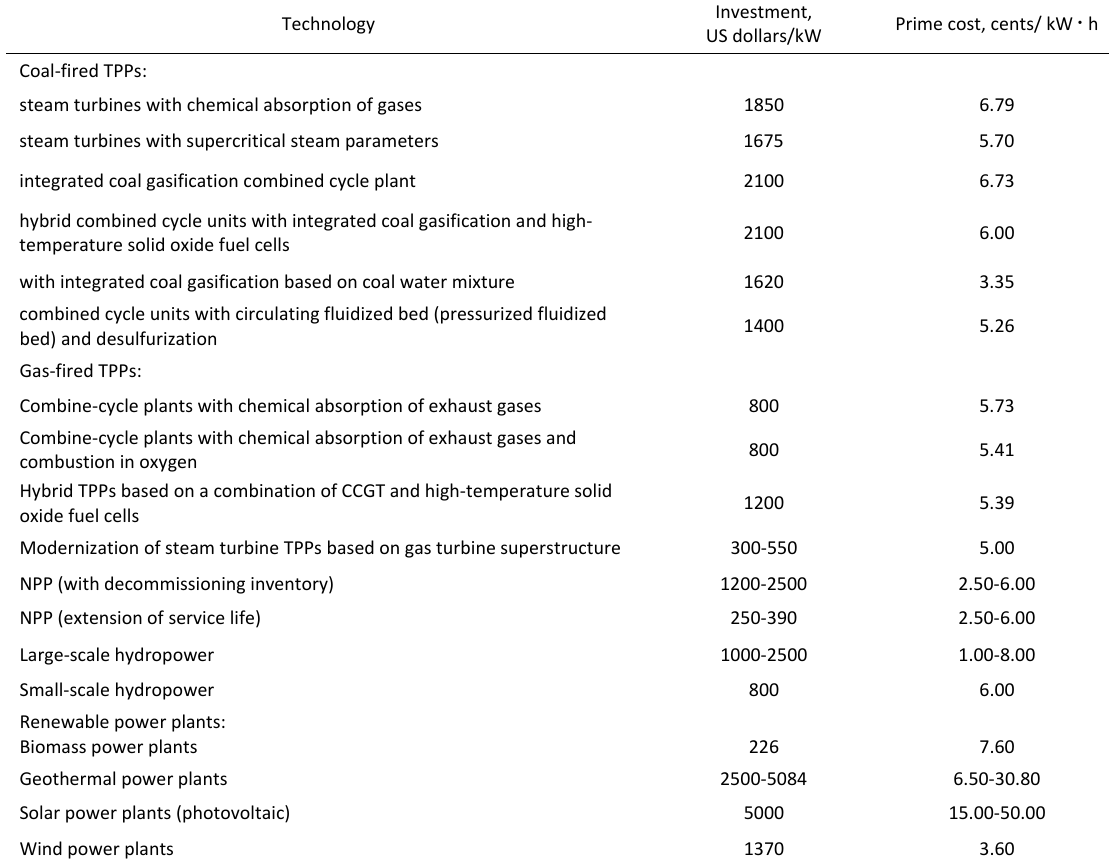
Table 2: Estimated cost of new capacities and prime cost of electricity